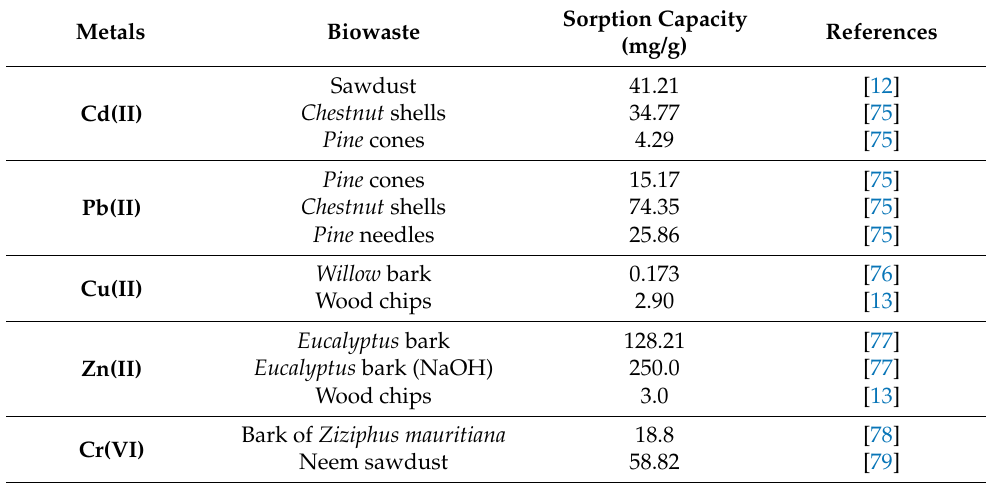
Table 2. Biowaste from the wood processing industry used to remove heavy metals from